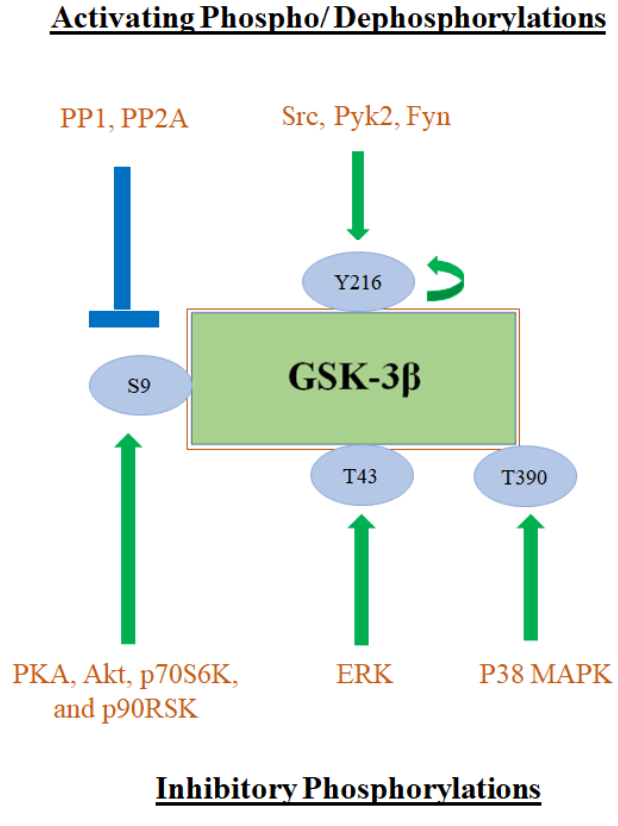
Figure 1. Phosphorylation sites of GSK-3 β . Green arrows show phosphorylation. Blue lanes show dephosphorylation.